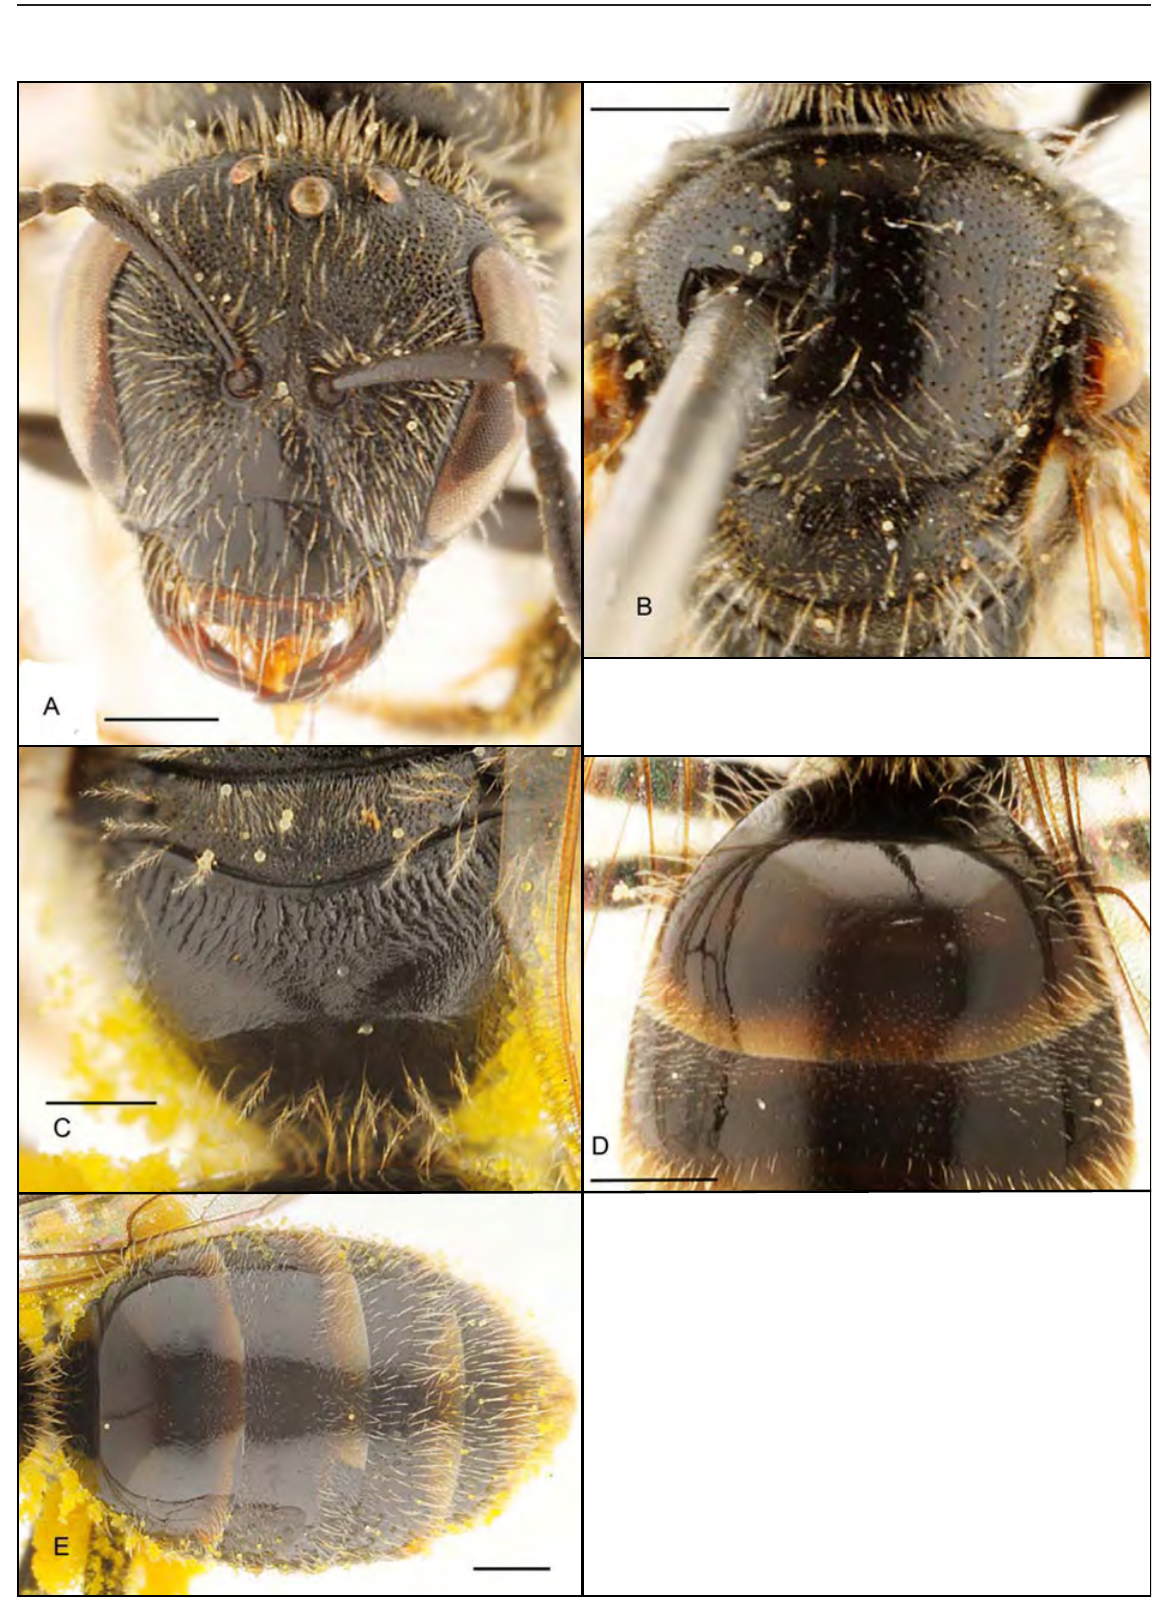
Fig. 5. Lasioglossum ( Capalictus ) hantamense sp. nov., ♀. A . Head. B . Mesoscutum and scutellum. C . Propodeum and metanotum. D . First tergum. E . Metasoma. Scale line = 0,5